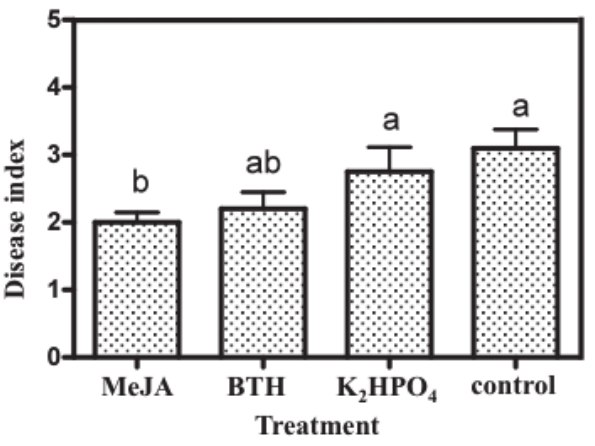
Figure 2. Effect of soaking melon seeds in methyl jas- monate (MeJA), acybenzolar-S-methyl (BTH) and dipo- tassium hydrogenphosphate (K HPO ) on the disease 2 4 index in melon roots growth in soil artificially inoculated with Monosporascus cannonballus . data are the means of two separate experiments ± SE. data followed by the same letters are not significantly different at P ≤0.05 (dunn test).